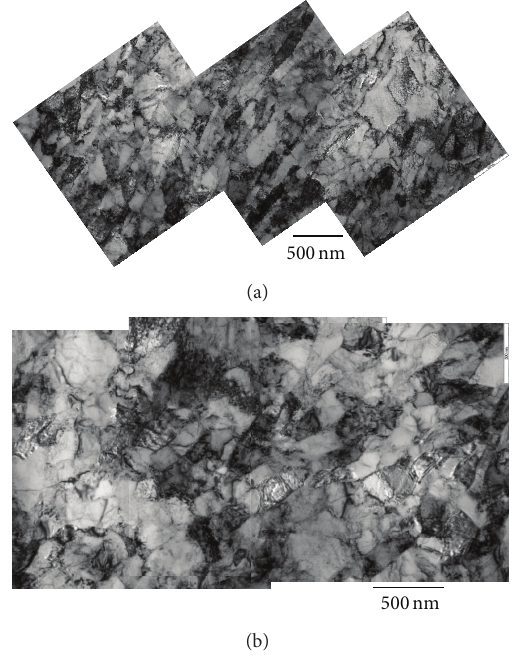
Figure 7: TEM micrographs (a) after eight passes ECAP and (b) after post-ECAP annealing at 698 K.